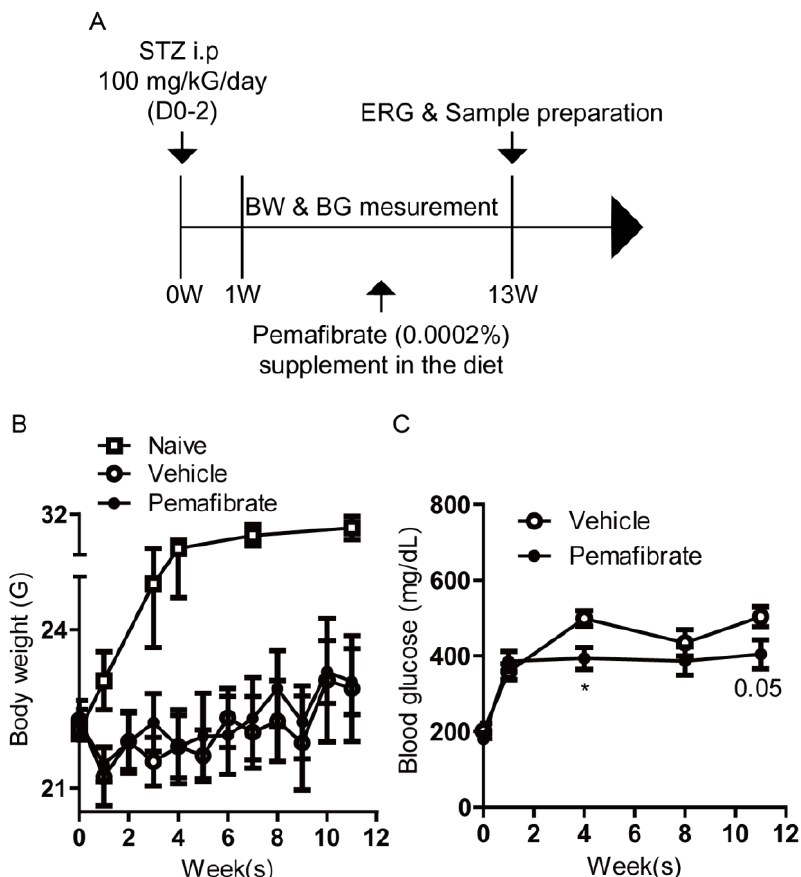
Figure 1. Schematic of the STZ-induced diabetic mouse model procedure and general observations. ( A ) A schematic illustration showing the STZ-induced diabetic model procedure and administration of pemafibrate to mice. BW; body weight, BG; blood glucose, ERG; electroretinography, STZ; streptozotocin, i.p; intraperitoneal injection. ( B ) Quantitative analysis ( n = 3–8 per group) showed that body weight of the STZ-induced mice was lower than that of naive mice. There was no significant difference in body weight between pemafibrate-administered mice and vehicle-administered mice. ( C ) Quantitative analysis ( n = 3–8 per group) showed that blood glucose level in pemafibrate-administered mice was lower than that in vehicle-administered mice only on week 4. * p < 0.05. Line graphs are presented as mean with ± standard deviation. The data were analyzed using Student’s t - test.